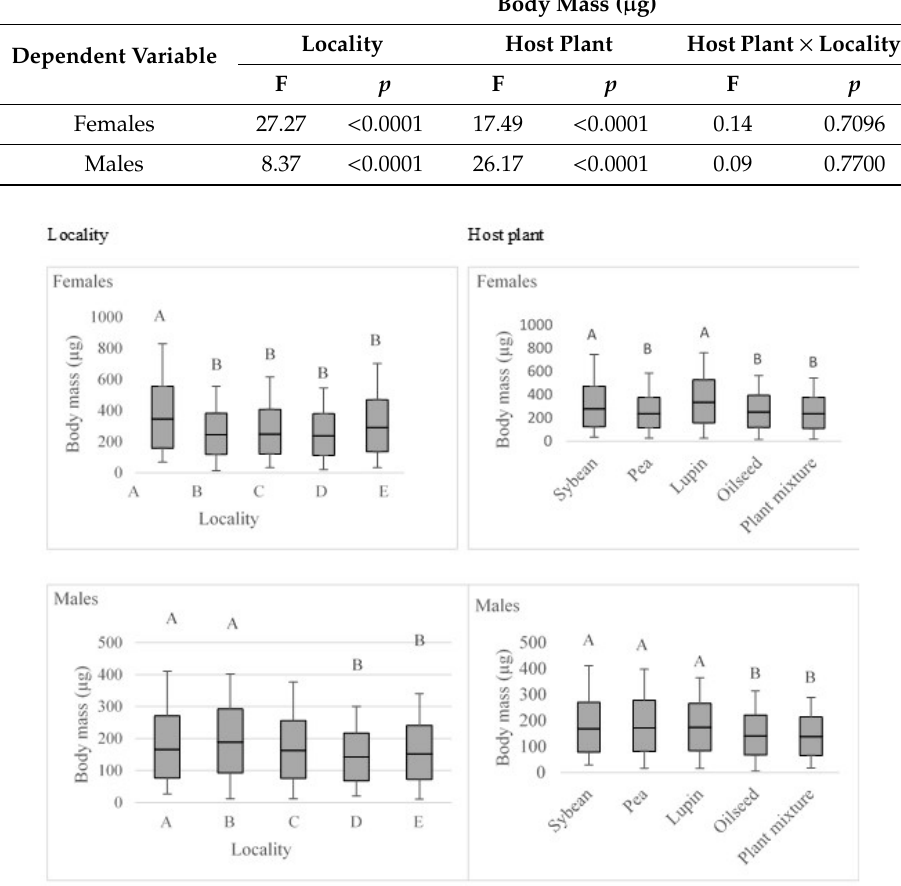
Figure 4. Body mass response to locality and host plant for females and males. *Different upper-case letters indicate significant differences between experimental treatments